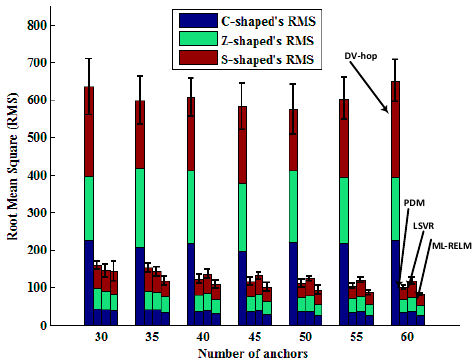
Figure 12. Comparison of different algorithms with different number of anchor nodes in the random deployment.